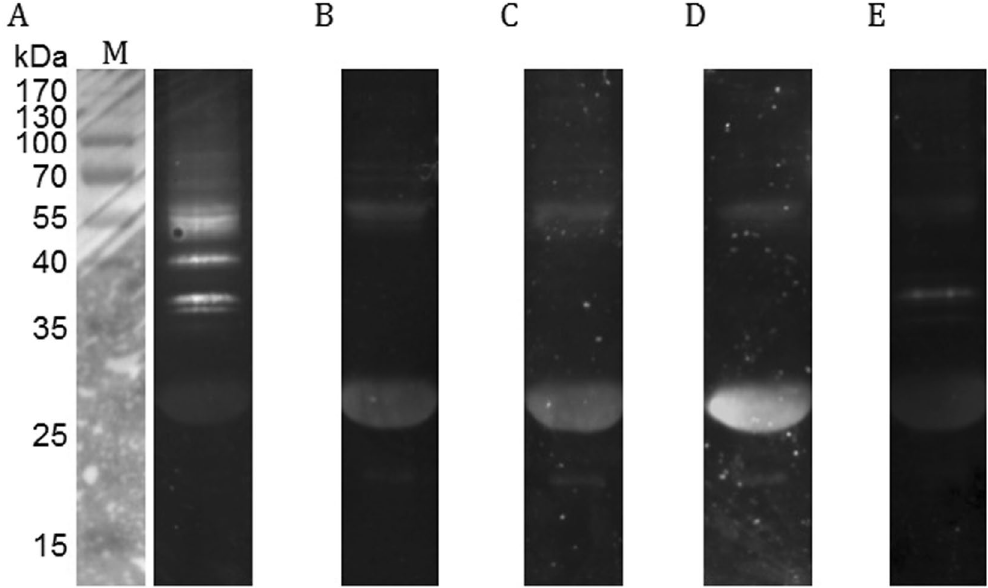
Figure 3. Western blot analysis of ubiquitylated proteins associated with the polyhedra matrix of BmNPV. Polyhedra matrix proteins were separated on SDS-PAGE gel and then analyzed using mouse monoclonal anti- ubiquitin antibody clone FK2 ( A ) and FK1 ( B ), rabbit monoclonal anti-ubiquitin antibody Lys48-specific clone Apu2 ( C ) and Lys63-specific clone Apu3 ( D ), and mouse monoclonal anti-linear poly-ubiquitin antibody clone LUB9 ( E ). Images were visualized using a secondary antibody conjugated to HRP and a chemiluminescence detection system.